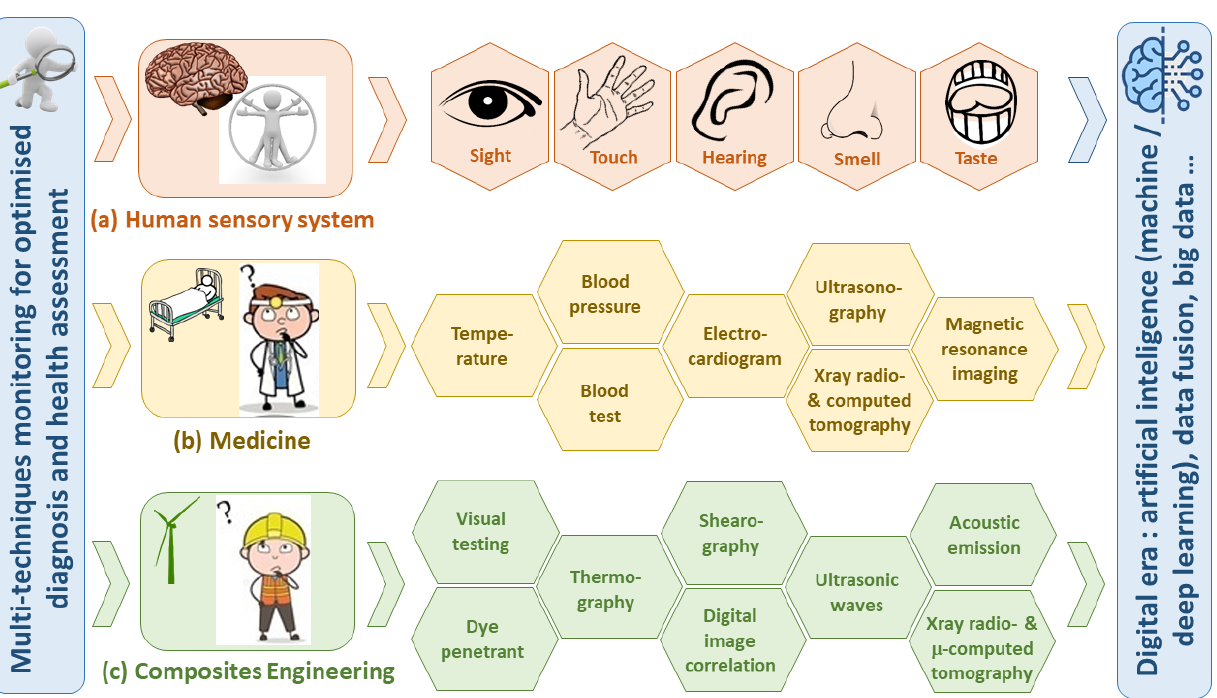
Figure 13. Comparison of “health” assessment in ( a ) nature, ( b ) medicine, and ( c ) materials engi-